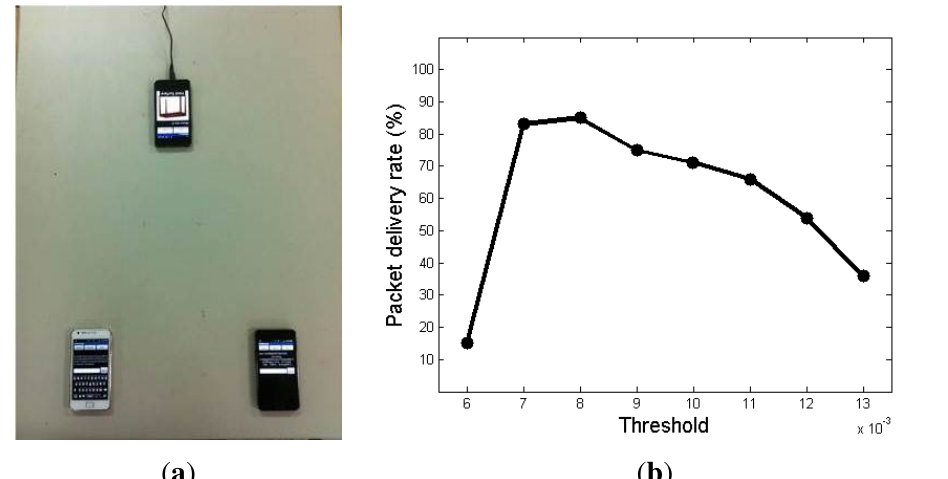
Figure 12. The experimental setup to test the effect of the detection threshold on ambient noise. The transmitter is located on the left bottom, and the receiver is located on the right bottom. The noise source is placed at the top of the photo. The packet delivery rate as a function of the detection threshold under the presence of a noise source. ( a ) Overall setting; ( b ) packet delivery rate under noisy